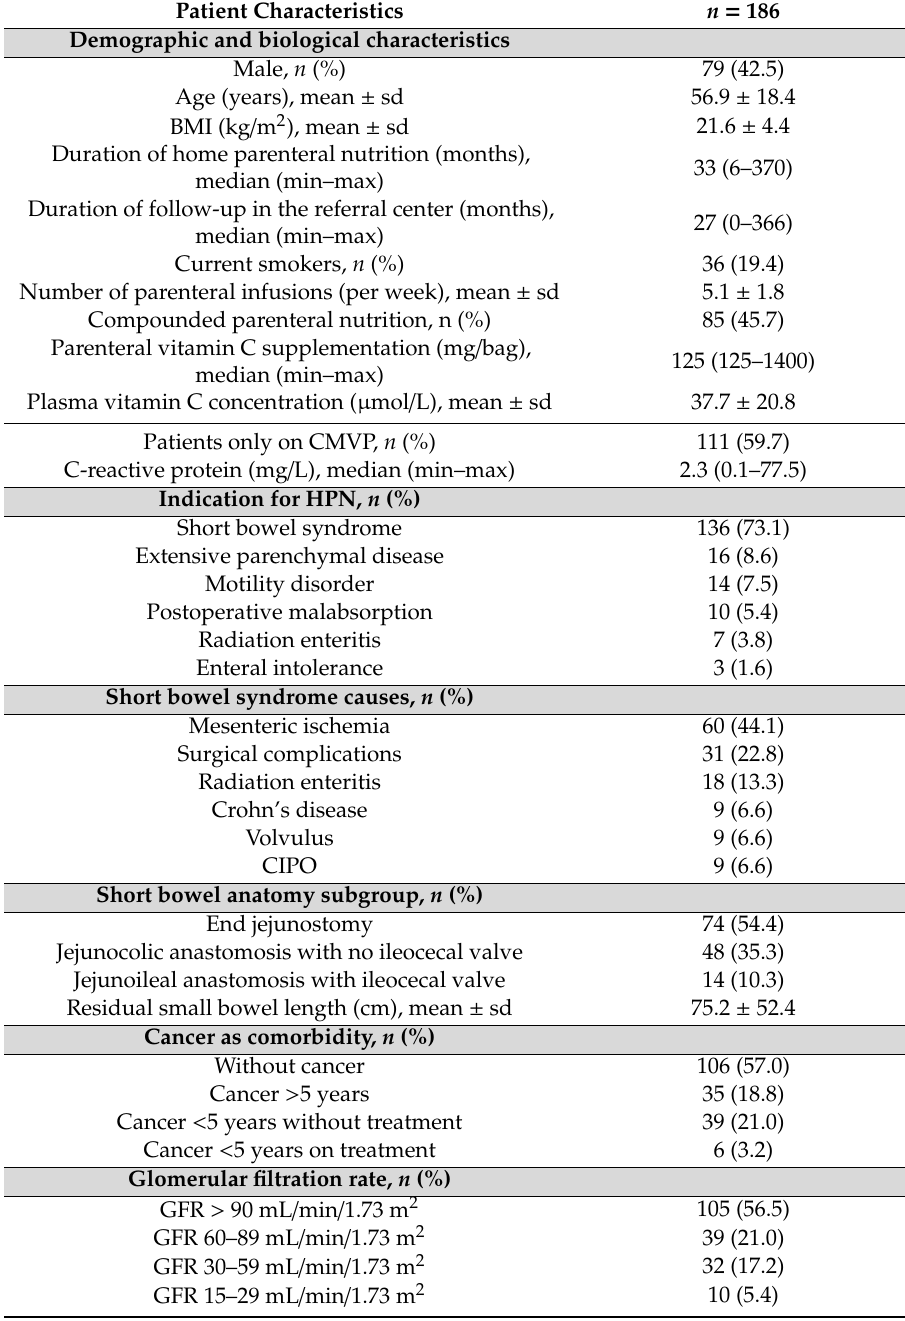
Table 1. Patient